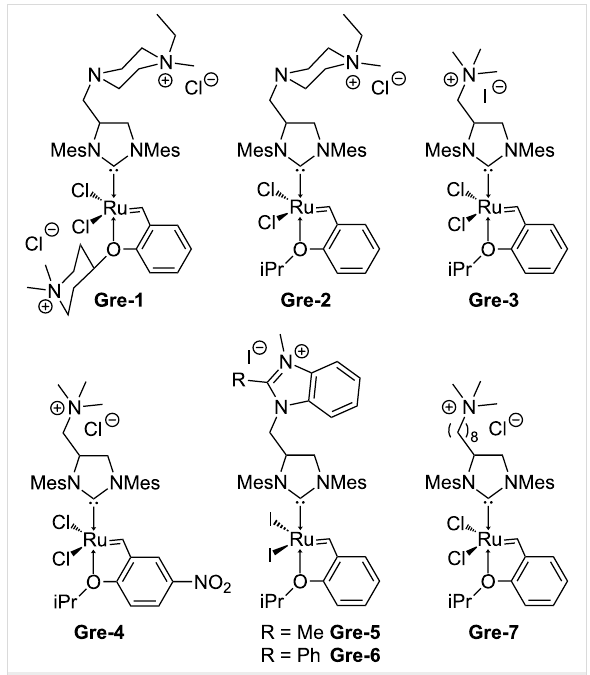
Figure 1: Catalysts synthesized by post-assembly tagging (Mes = mesitylene)